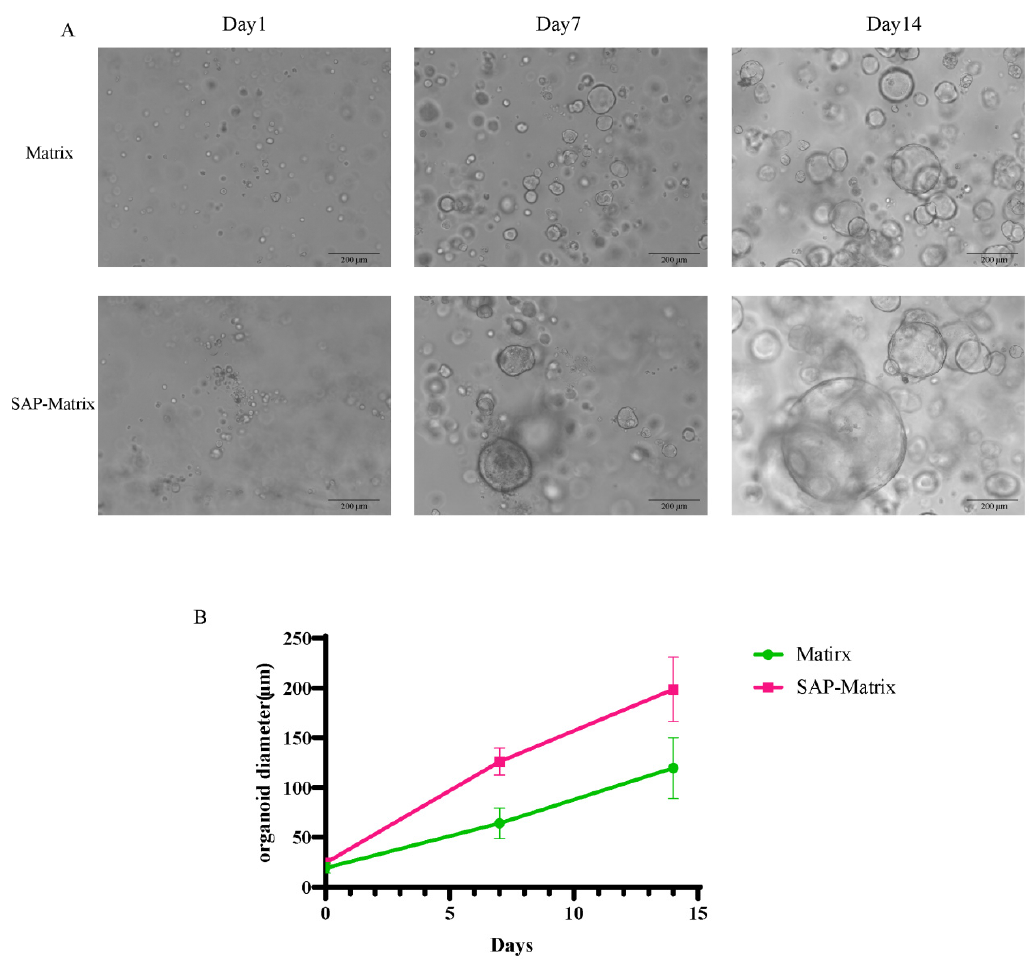
Figure 3. Morphology and growth curve analysis of organoids in the SAP-Matrix and Matrix. ( A ) Microscopic morphology of organoids of Caco-2 with SAP-Matrix and Matrix on day 1, 7, and 14; ( B ) growth curve trend of organoids of Caco-2 with SAP-Matrix and Matrix in 14 days.